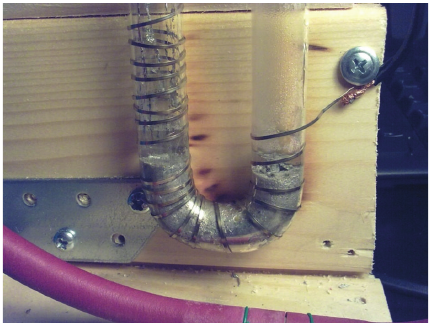
Figure 3: Water sucked by the